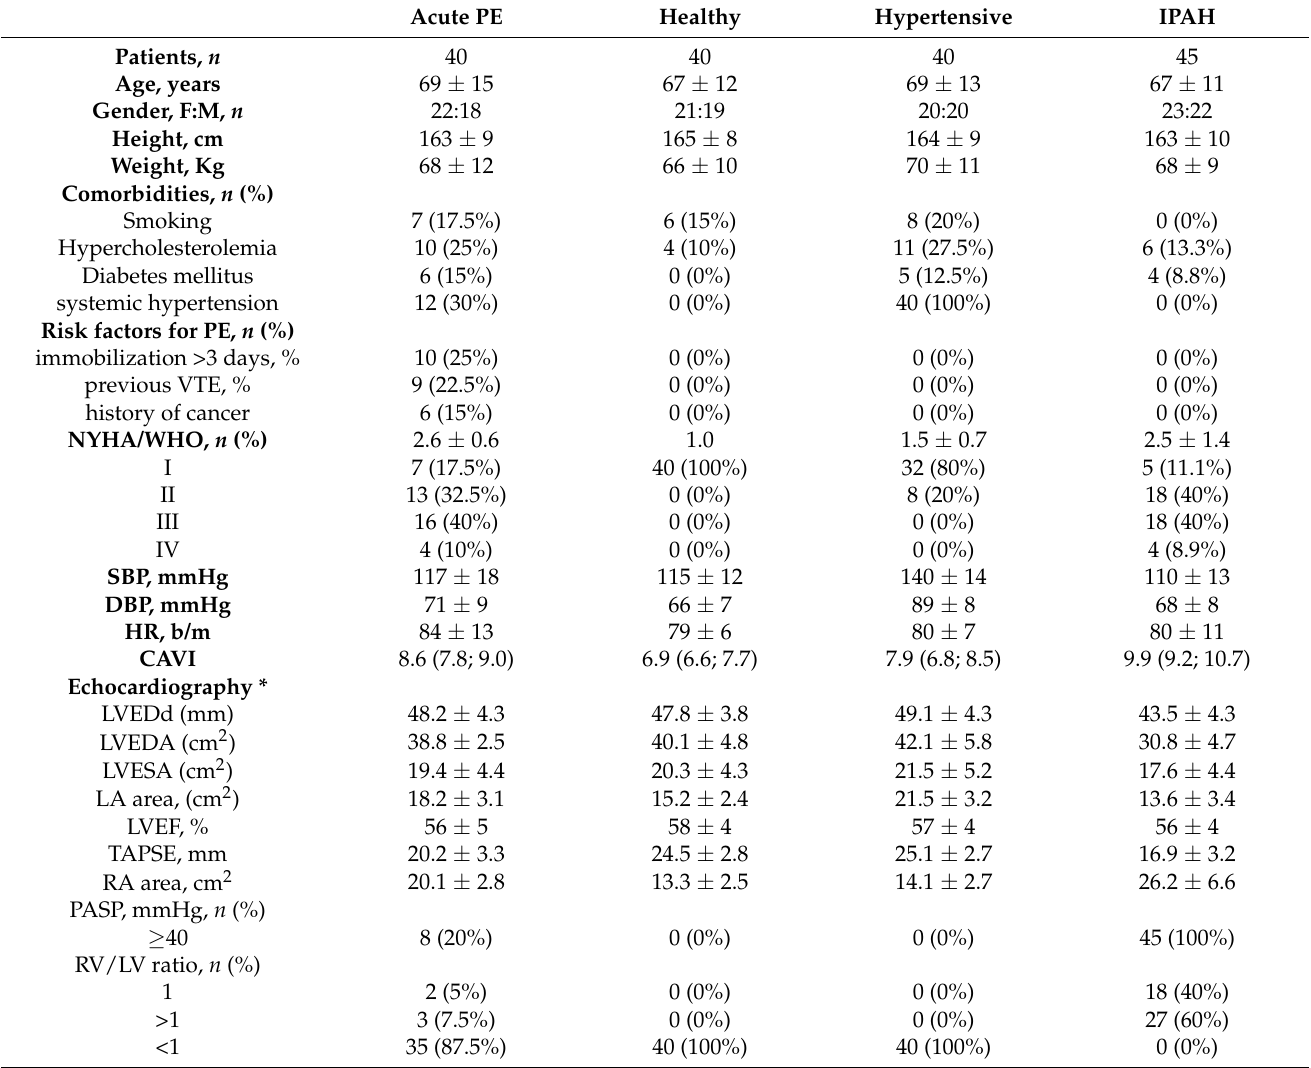
Table 1. Baseline demographic and clinical characteristics of the study